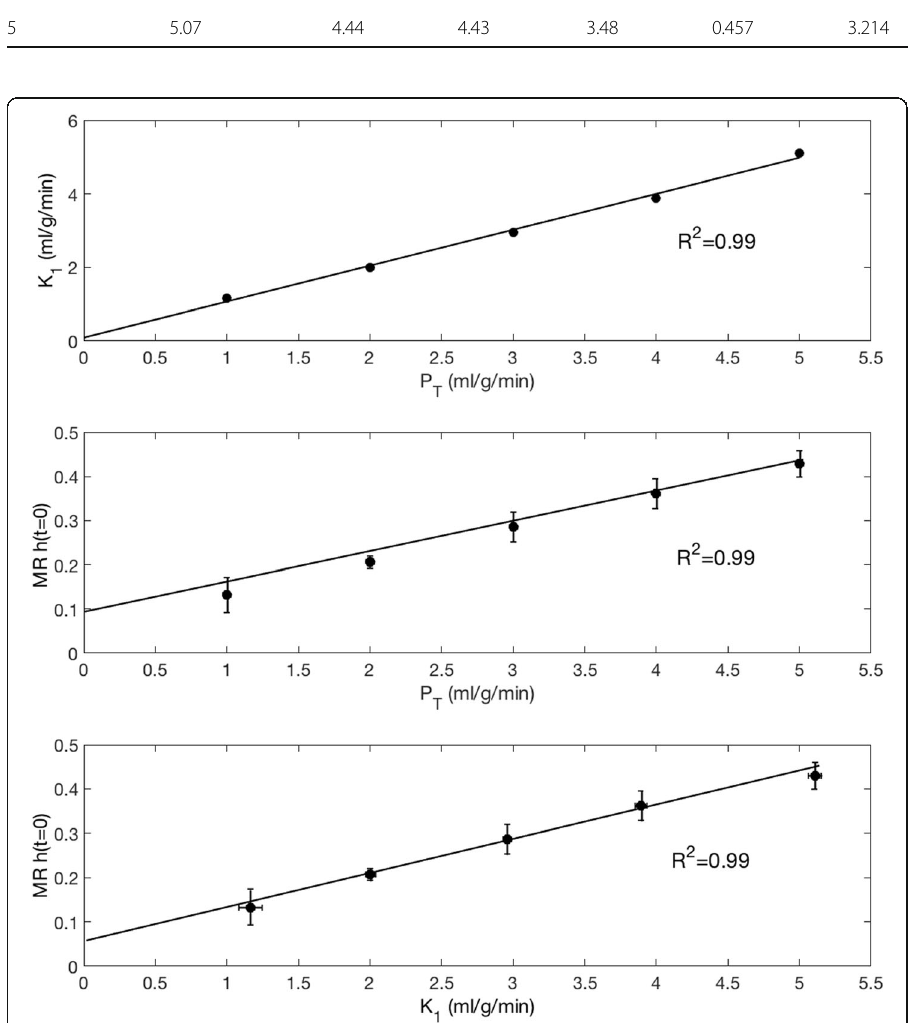
Fig. 6 Top - Resulting K 1 values from a single compartment model for PET data plotted against P T . Middle – MR values of h(t = 0) from model-independent deconvolution for MR images plotted against the range of P T . Bottom - MR values of h(t = 0) plotted against the range of K 1 from PET kinetic